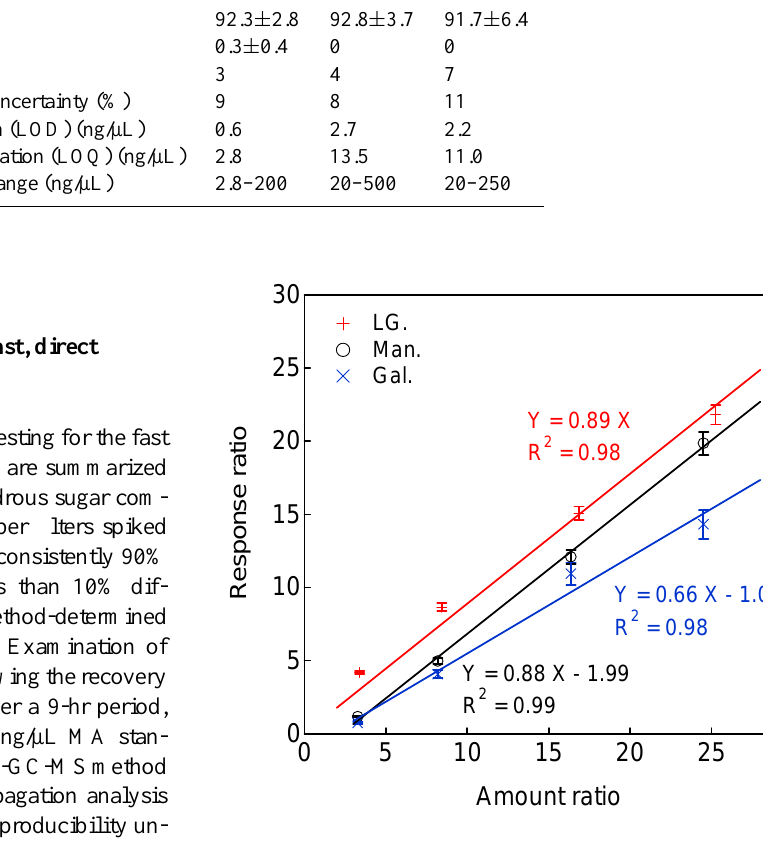
Fig. 1. Multi-level LG (+), MAN ( (cid:13) ), and GAL (X) calibration data with linear fit. All responses are normalized to deuterated LG internal standard